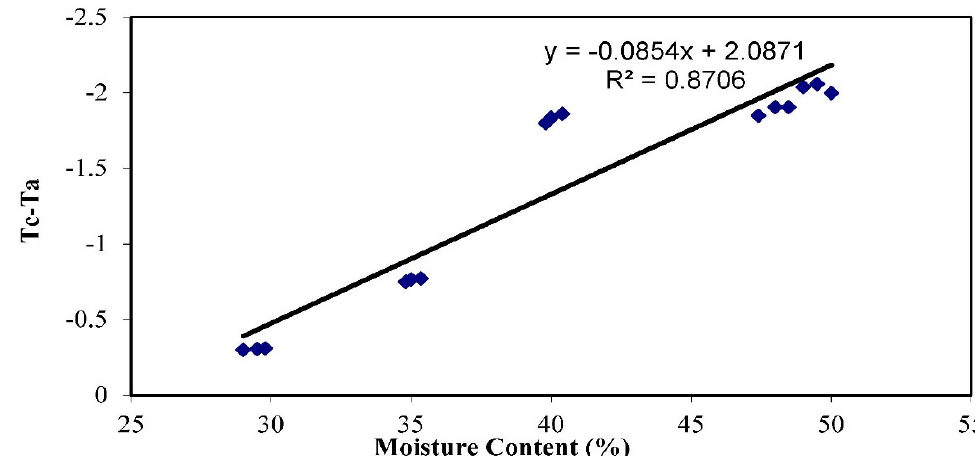
Figure 3. Relationship between (Tc–Ta) and moisture contents (%).